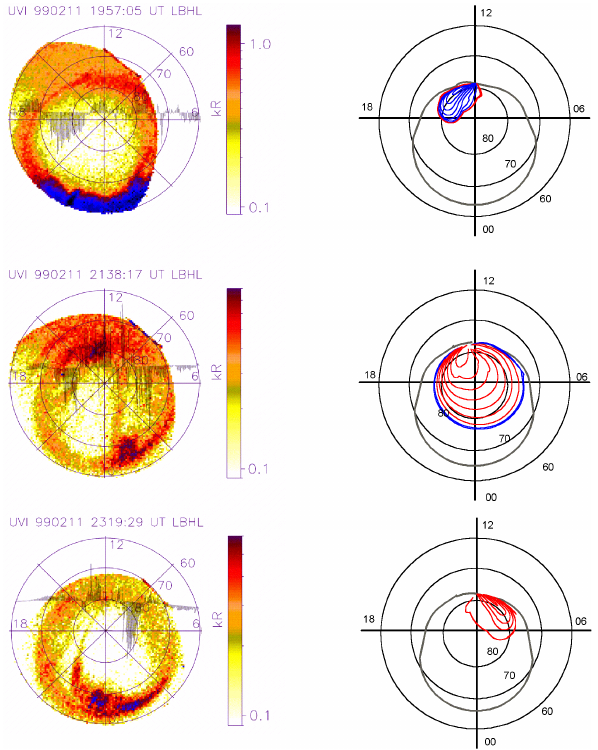
Fig. 12. Left: Data shown from three DMSP passes on 11 February 1999 (19:46–20:06, 21:29–21:49, and 23:10–23:30 UT) that occur during the Polar UVI data period. DMSP F13 horizontal plasma flows, perpendicular to the satellite track are plotted over a UV im- age taken at the time when F13 is at highest magnetic latitudes. Right: For the same 3 times are shown the model calculations of the polar cap boundary, auroral oval, and polar cap convection gen- erated by solar wind electric field, all derived from the Paraboloid Model. The model parameters for each case were calculated from solar wind data and geomagnetic indices. See text for details.